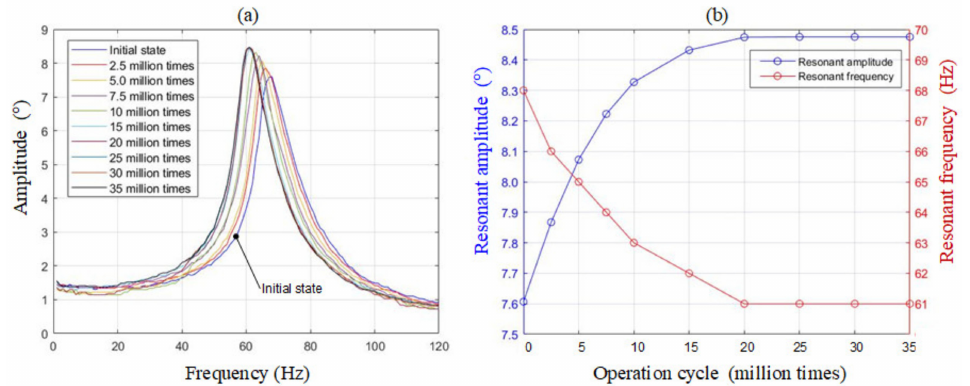
Figure 7. ( a ) Spectrums of the proposed system. ( b ) Origami hinges are softened along with increasing operation